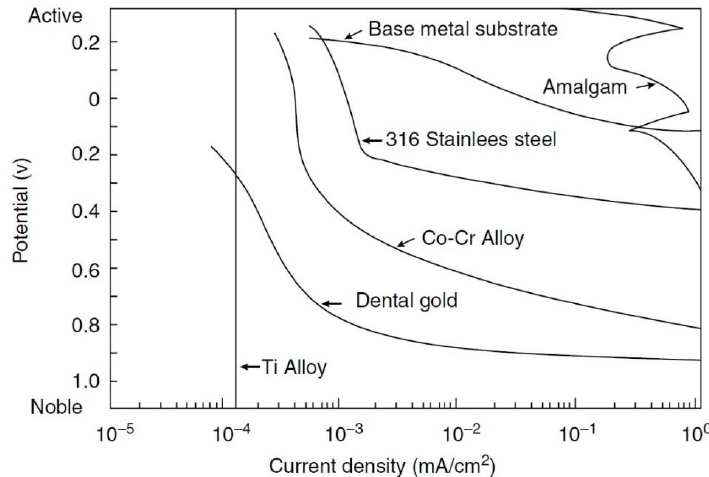
Figure 8. Polarization curves for some biomaterials. Reprinted from Greener et al. [125].